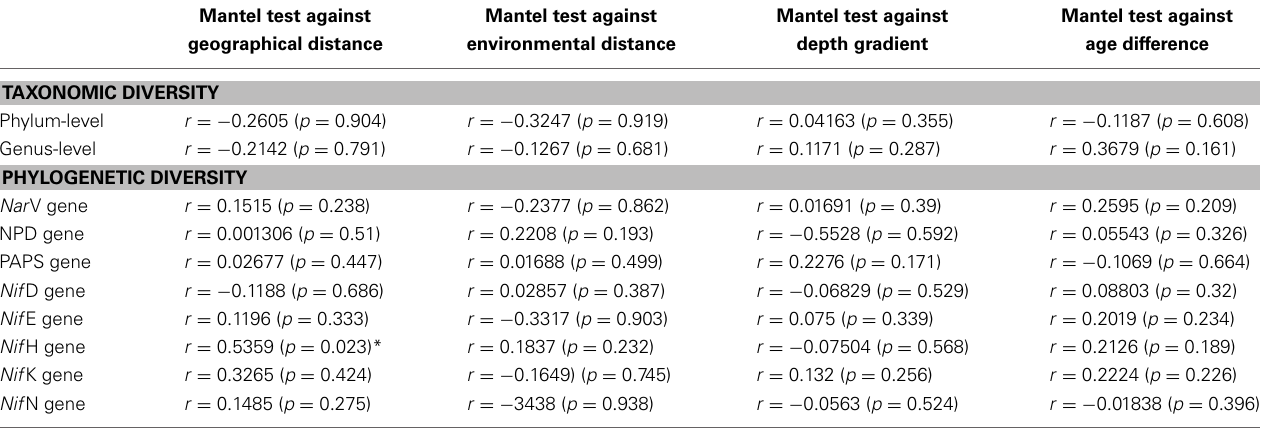
Table 2 | Spearman correlation coefficients and significance values of Mantel tests between biological distance matrices and distance matrices of abiotic